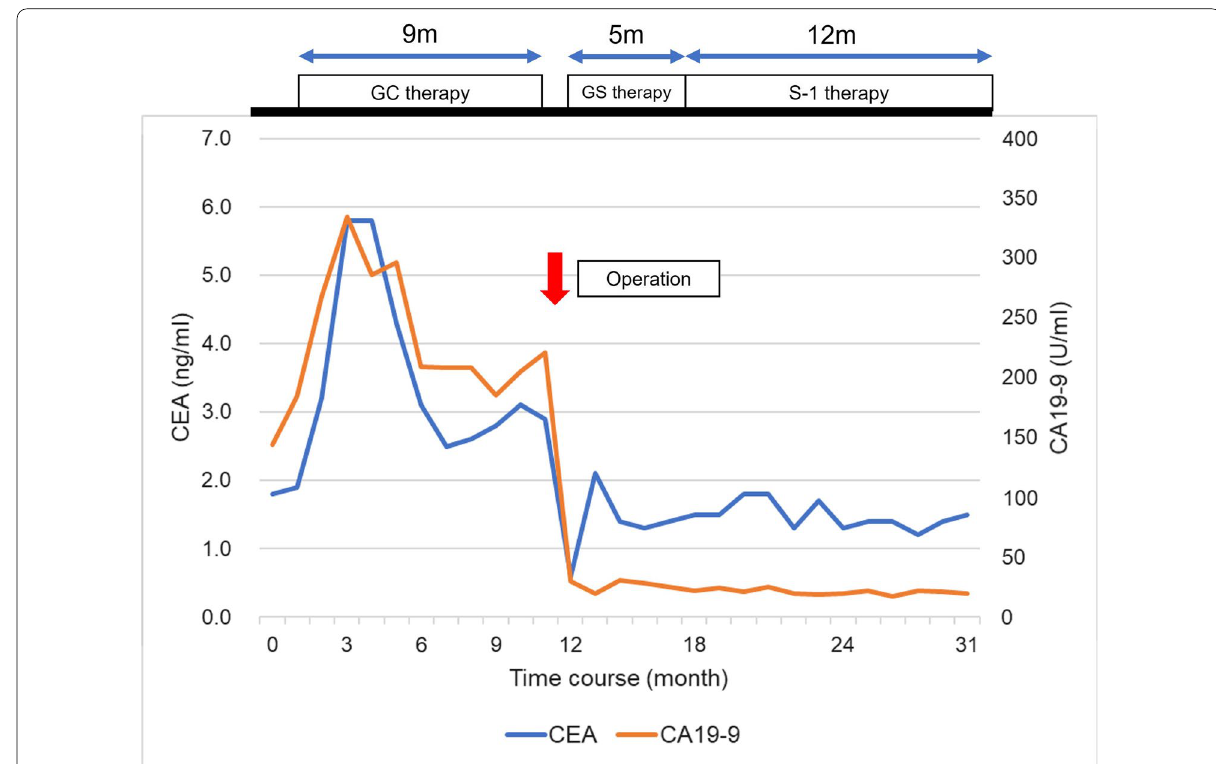
Fig. 2 Clinical course of treatment after hospitalization and changes in CEA and CA19-9 levels. CEA, carcinoembryonic antigen; CA19-9, carbohydrate antigen